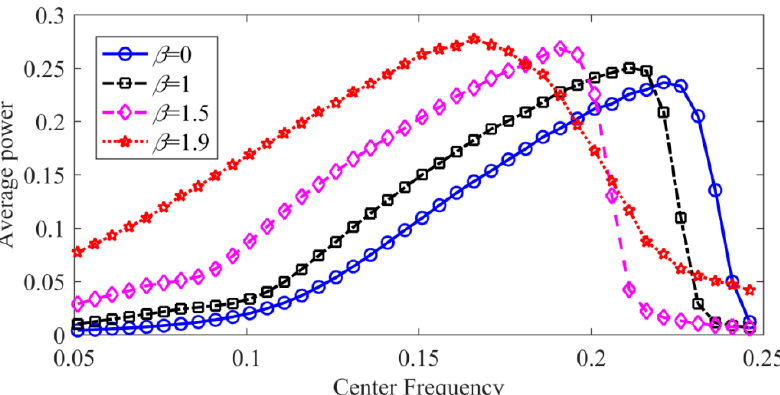
Figure 14. Influence of center frequency on the output performance of the asymmetric MEH excited by band-limited noise when with different values of the quadratic